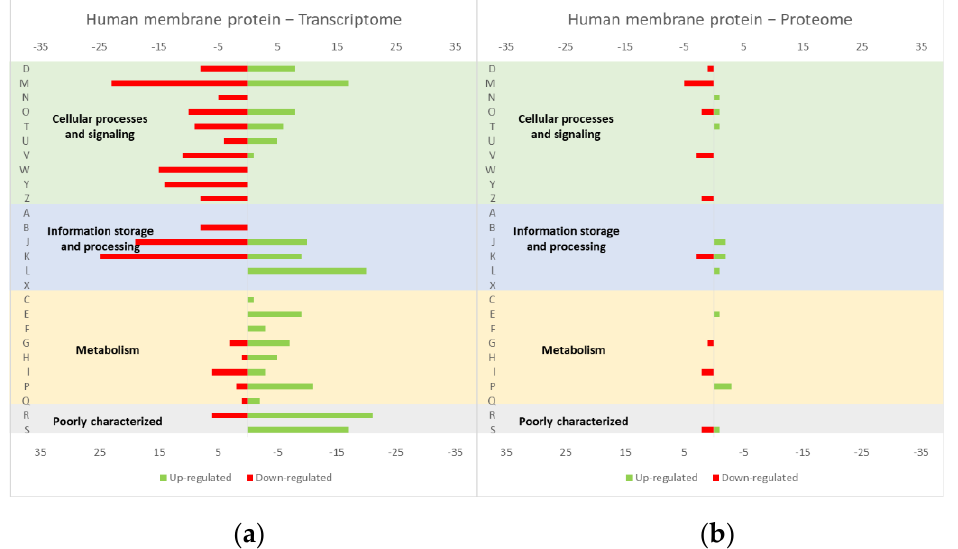
Figure 3. Effect of the PS1Δ9 expression in the L. lactis ( a ) transcriptome and ( b ) proteome. The graphs were constructed with compiled data from Marreddy et al. [30] and represent the total number of transcripts or proteins up or down-regulated in each cellular process, when compared with the strain harboring the empty vector. The letters on the yy axis correspond to the COG categories: A, RNA processing and modification (not used for prokaryotic COGs), B, chromatin structure and dynamics, C, energy production and conversion, D, cell cycle control and mitosis, E, amino acid metabolism and transport, F, nucleotide metabolism and transport, G, carbohydrate metabolism and transport, H, coenzyme metabolism, I, lipid metabolism, J, translation, K, transcription, L, replication and repair, M, cell wall/membrane/envelope biogenesis, N, Cell motility, O, post-translational modification, protein turnover, chaperone functions, P, Inorganic ion transport and metabolism, Q, secondary metabolites biosynthesis, transport and catabolism, T, signal transduction, U, intracellular trafficking and secretion, Y, nuclear structure (not applicable to prokaryotic COGs), Z, cytoskeleton (not applicable to prokaryotic COGs); R, general functional prediction only (typically, prediction of biochemical activity), S, function unknown